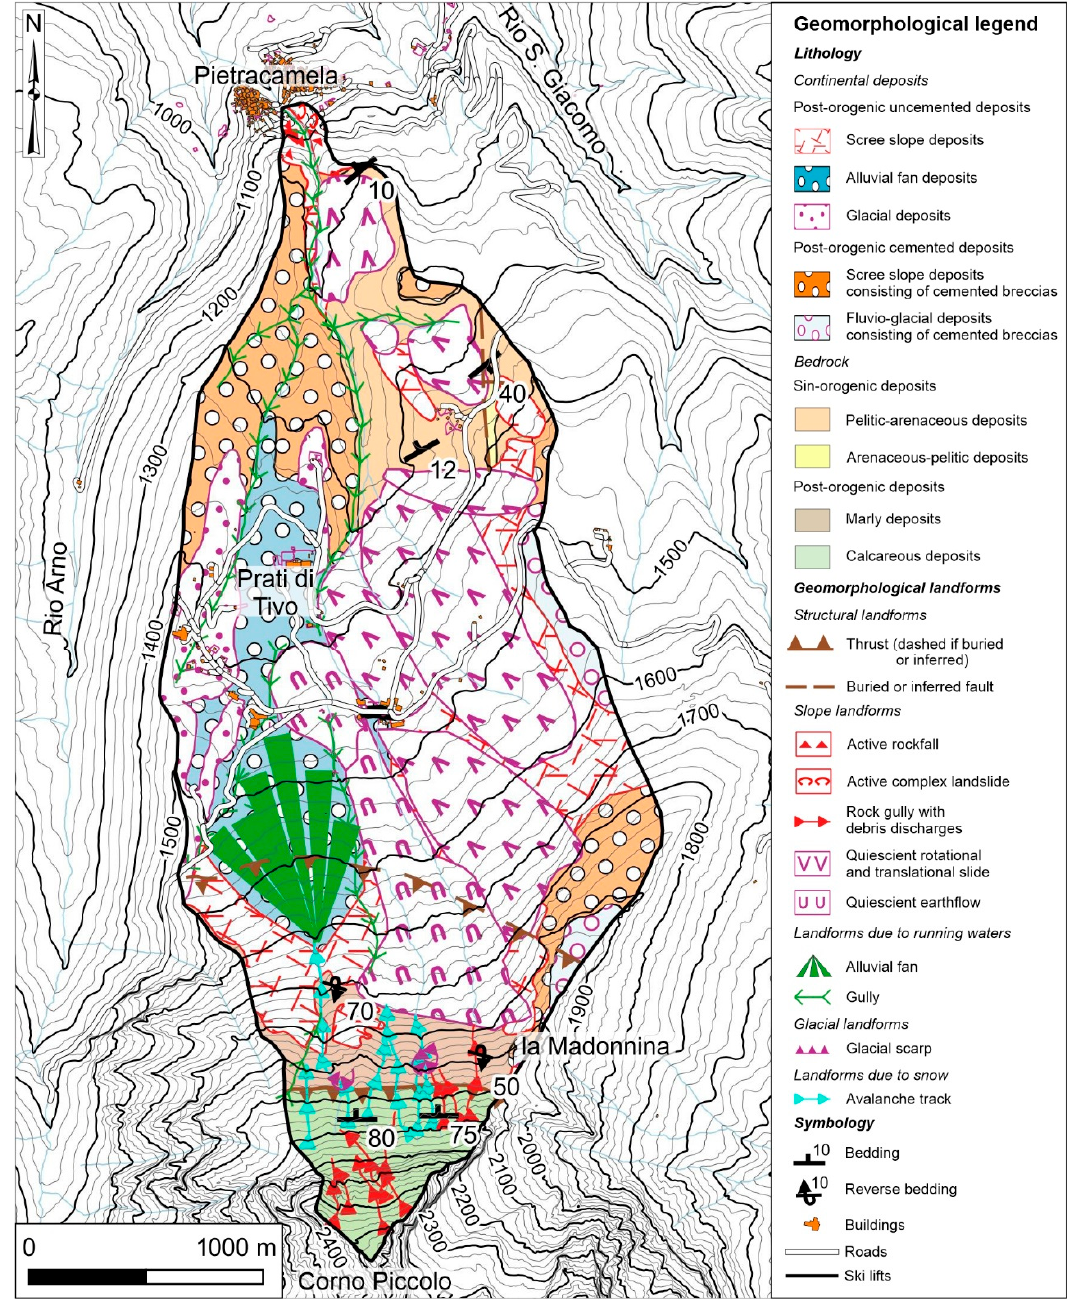
Figure 6. Simplified geomorphological map of the study area (modified and updated from [65,88,89]). The black line represents the study area.